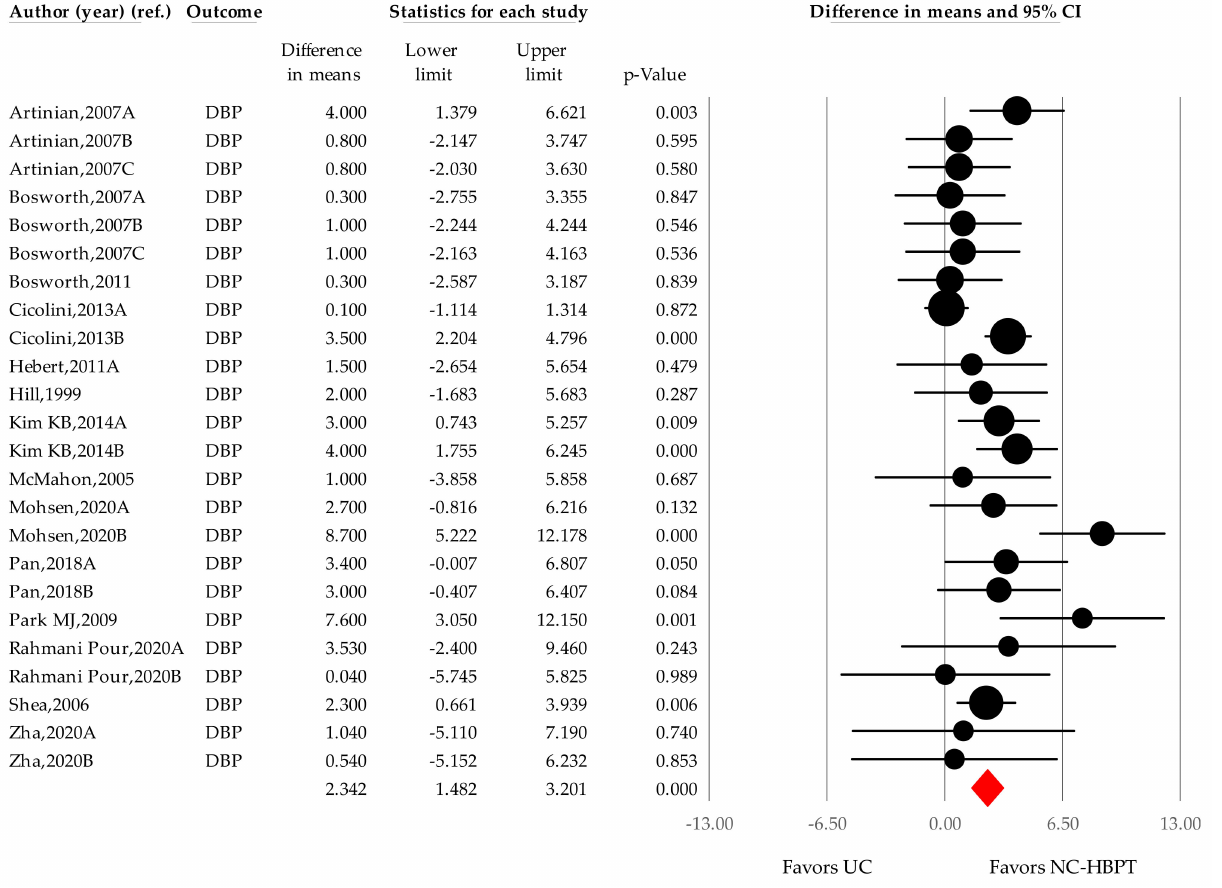
Figure 7. Difference in means of office diastolic blood pressure changes by nurse-coordinated intervention. Notes. Point Figure 6. Difference in means of office systolic blood pressure changes over time. Notes. Point estimate of individual study estimate of individual study ( • ); Summary effect size ( ( ● ); Subgroup ( ○ ); Summary effect size ( ◆ ); DBP, diastolic blood pressure; UC, usual care; NC-HBPT, nurse-coordinated home blood pressure